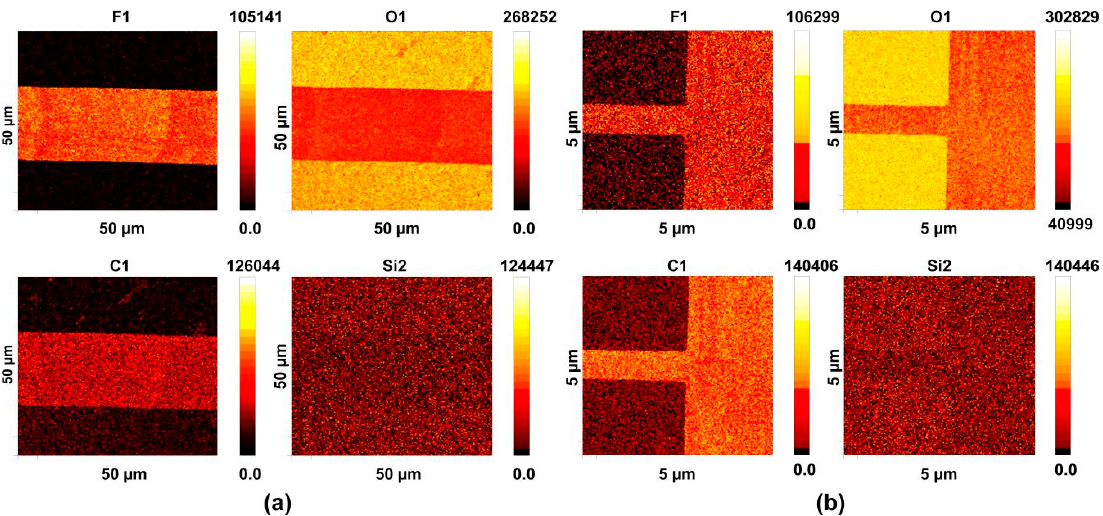
Figure 3. Reconstructed mapping image of KLL Auger electrons in two areas, fluorine Auger electrons, F1, oxygen Auger electrons, O1, carbon Auger electrons, C1, silicon Auger electrons, Si2. ( a ) The same area is shown in Figure 3a. ( b ) The area with a line width of 10 µm.